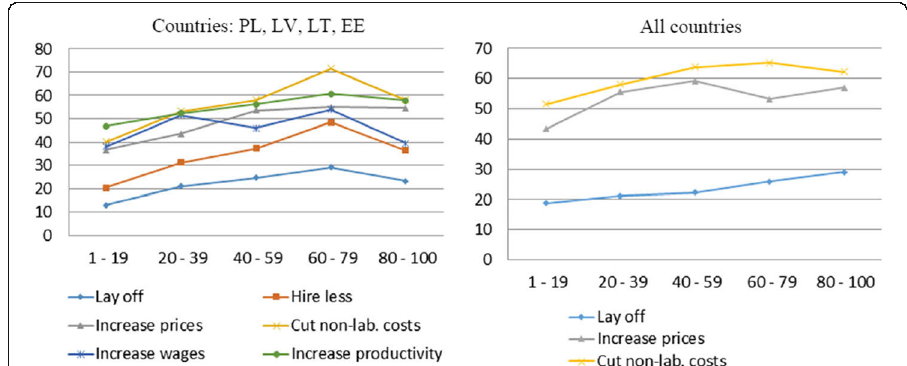
Fig. 1 Predicted probabilities to find the adjustment channel ‘ Relevant ’ for a given range of the share of employees earning the minimum wage at the firm. Note: Calculated using a multivariate probit model presented in Tables 12 and 13 in the Appendix, which include different shares of employees at the